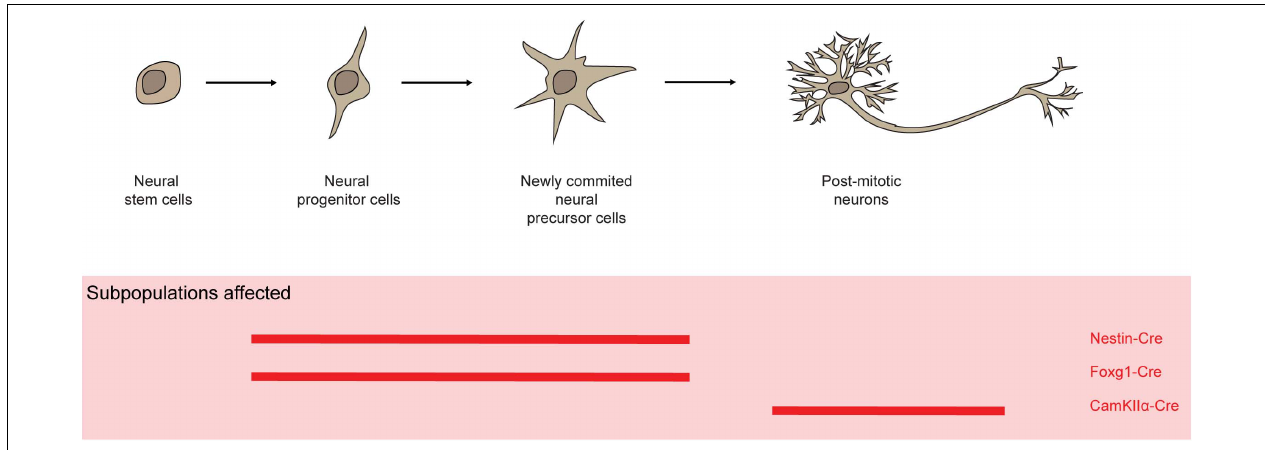
FIGURE 6 | Mcl-1 plays an important role for the survival of neurons and neural progenitor cells. In several conditional knock-out models (red solid line), Mcl-1 was shown to be crucial for the survival of neurons in both the developing and post-mitotic neurons in brain.